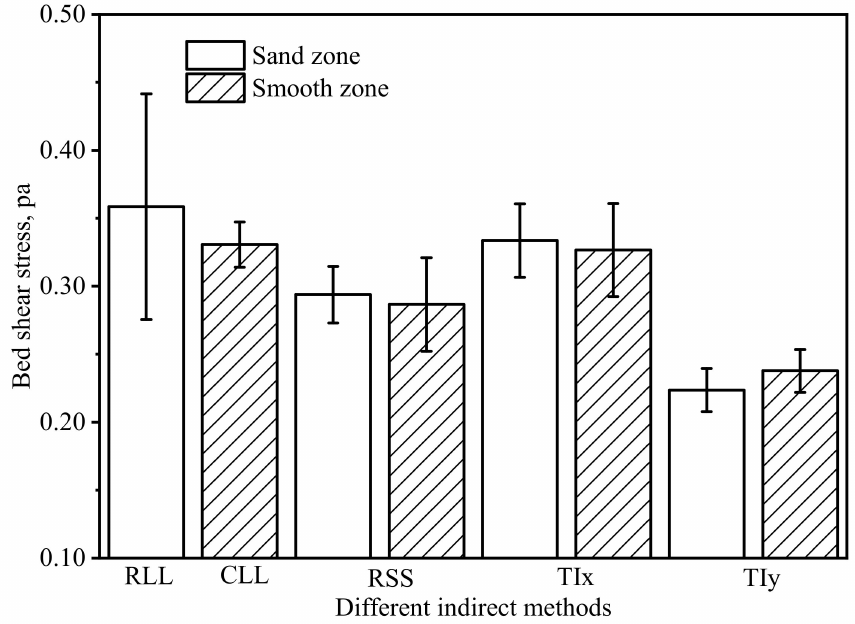
Figure 8. Bed shear stress estimated by different indirect methods in the sand zone and smooth zone. The error bars represent the 95% confidence intervals ( ± two standard